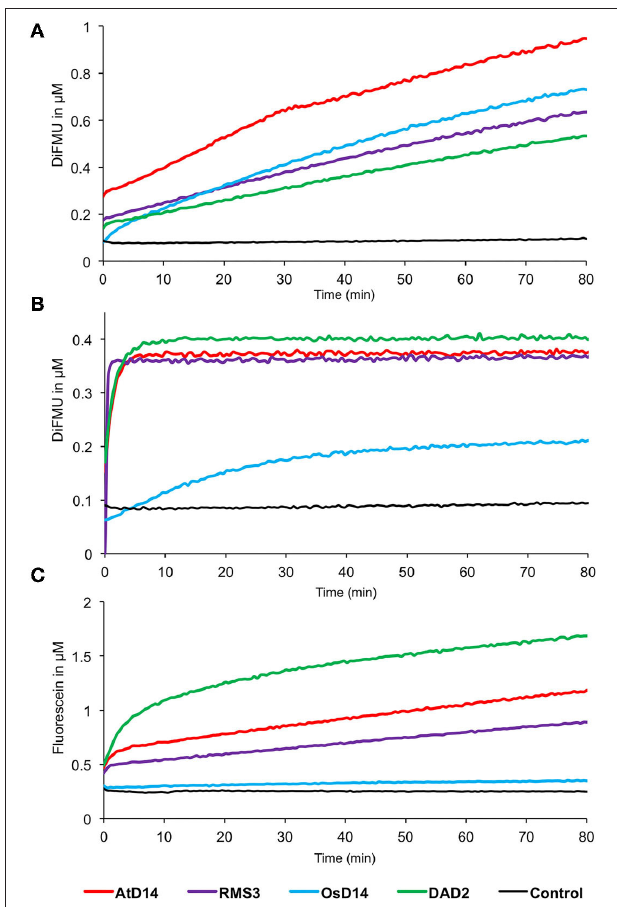
FIGURE 10 | Enzymatic kinetics for AtD14, RMS3, OsD14, and DAD2 proteins incubated with ( ± )-GC240 (A) , ( ± )-GC242 (B) , or ( ± )-YLG (C) . Progress curves during probes cleavage, monitored ( λ em 460nm for ( ± )-GC240 and ( ± )-GC242 and λ em 510nm for ( ± )-YLG) at 25 ◦ C. Protein catalyzed cleavage with 400nM of protein and 20 µ M of probes. These traces represent one of the three replicates, and the experiments were repeated at least two